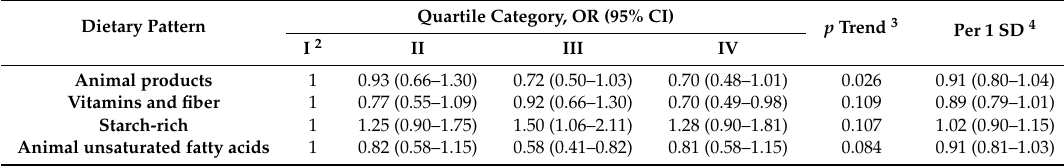
Table 4. Odds ratios (ORs) 1 of bladder cancer and corresponding 95% confidence intervals (CIs) on quartiles of factor scores from a principal component factor